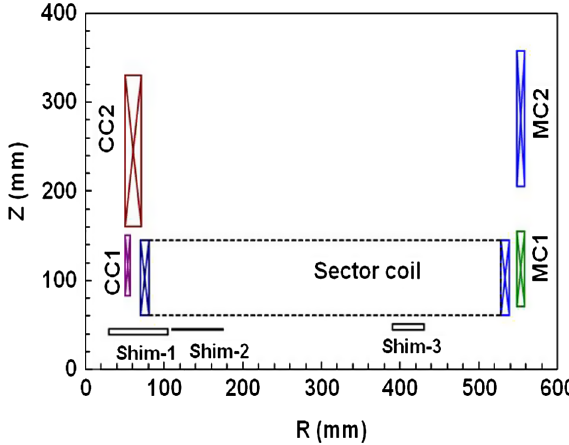
FIG. 6. Cross-sectional positions of circular coils, sector coil, and shims in the ( r - z ) plane.